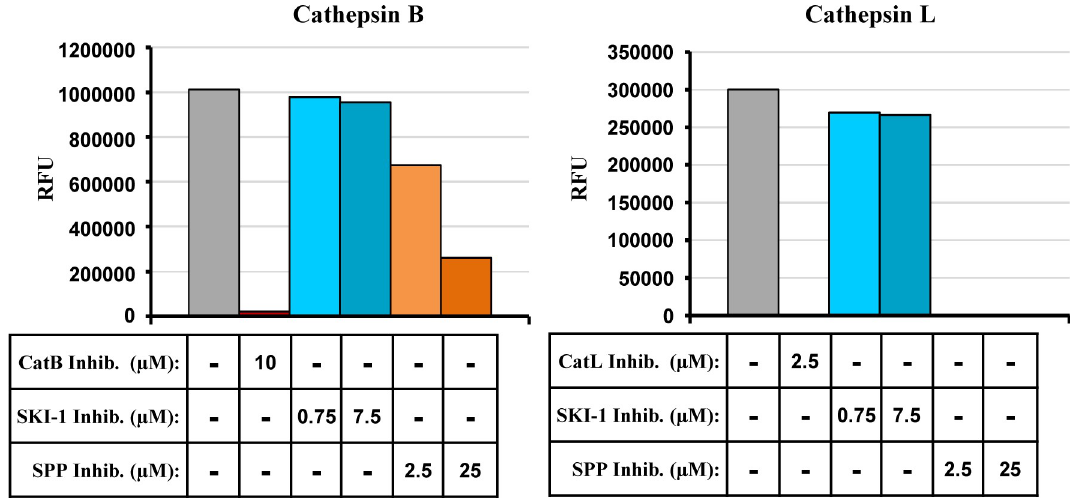
Fig 4. SPP inhibitor blocks the enzymatic activity of recombinant CatB and CatL. Cathepsin activities were determined by measuring the release of the fluorophore 7-amino-4-methylcoumarin (AMC) from peptide substrates Z-Arg-Arg-AMC (CatB) and Z-Phe-Arg-7-AMC (CatL). The results of a single representative experiment performed with duplicate samples are shown and were confirmed in a separate experiment. CatB inhibitor: CA074; CatL inhibitor: Z-FY(t-Bu)-DMK; RFU, relative fluorescence units.